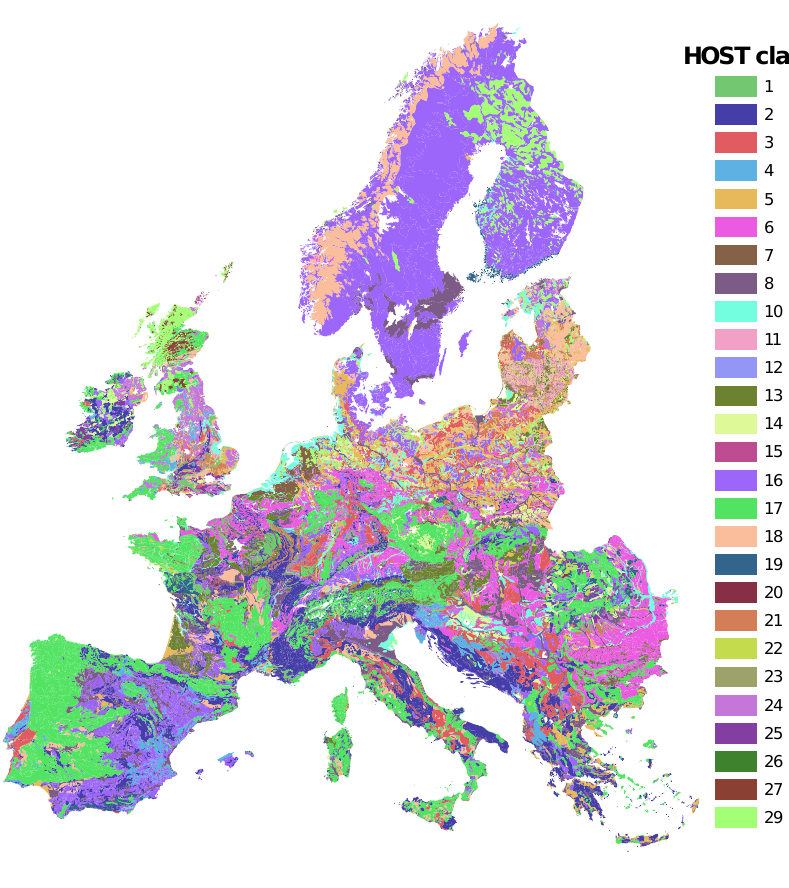
Fig. 2. Soil Geographical Database of Europe (SGDBE) reclassified into HOST classes. Colours for each HOST class are identical to Fig. 1. SGDBE polygons are copyright of the Commission of the European